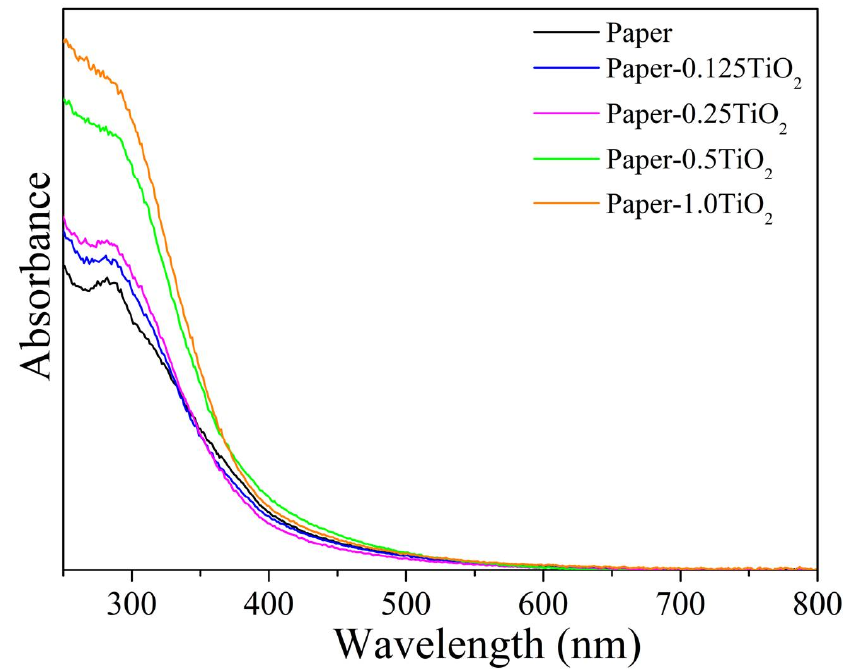
Figure 8. UV–Vis di ff use reflectance spectra of TiO 2 -modified paper sheets with di ff erent loading of Figure 8. UV–Vis diffuse reflectance spectra of TiO 2 -modified paper sheets with different loading of TiO 2 TiO 2 hydrosol.